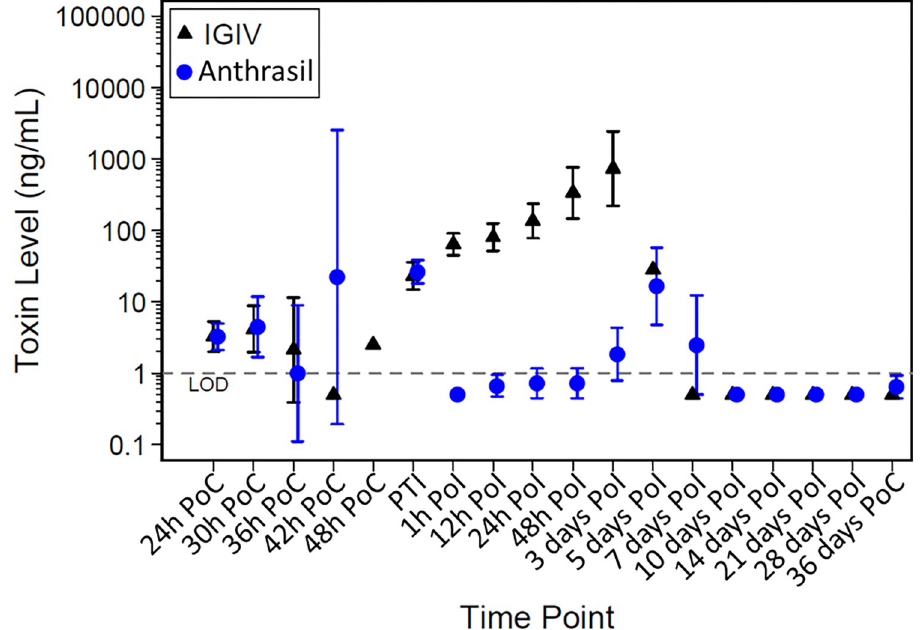
Fig 2. Mean toxin levels in B . anthracis -infected rabbits treated with IGIV or ANTHRASIL. Plot of geometric means of toxin levels and 95% confidence intervals over time on the log-scale in B . anthracis spore-challenged rabbits that received a full dose of IGIV or ANTHRASIL and were bacteremic at least once prior to treatment (MITT analysis set). Animals received treatment following the detection of toxemia, which was observed from 24 h to 48 h post-